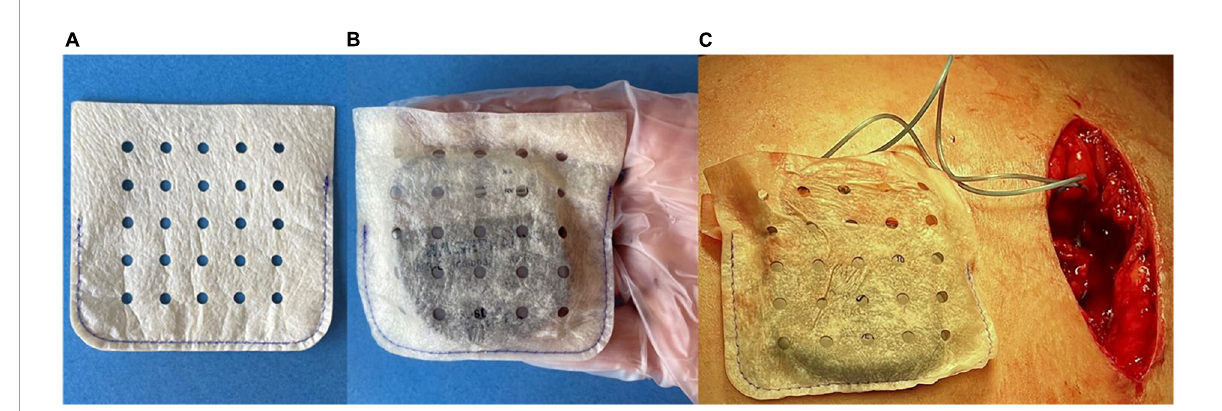
FIGURE1 (A) A medium-size biologic CanGaroo R (cid:13) Envelope made from 4-ply lyophilized, decellularized, non-crosslinked extracellular matrix derived from porcine intestinal submucosa (SIS ECM). (B) Once hydrated by the implanting physician per manufacturer instructions, the biologic envelope handles well and conforms to the device. (C) Intraoperative photo of the hydrated biologic envelope just prior to being placed within the tissue